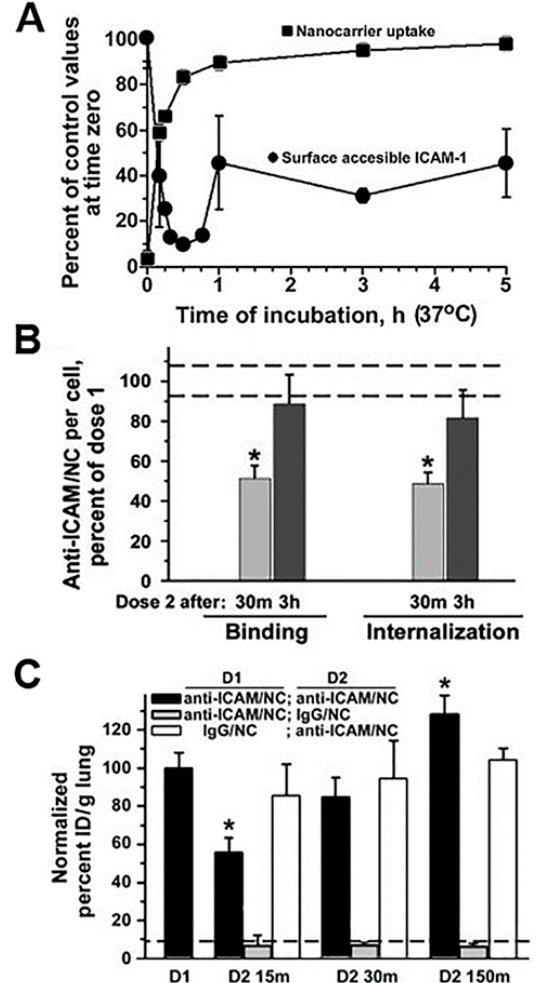
Figure 6. Endocytic alterations caused by drug carriers. ( A ) Kinetics of endocytosis of via intercellular adhesion molecule 1 (ICAM-1)-targeted polymer nanocarriers (anti-ICAM/NCs) by HUVEC cells (traced by fluorescence microscopy) and that of cell surface levels of ICAM-1 receptor during nanocarrier uptake (traced by radioactive labeling). ( B ) Relative level of binding and endocytosis of anti-ICAM/NCs applied as a second dose to HUVEC cells (and traced by fluorescence microscopy), either 30 min or 3 h after a first dose of NCs. * p < 0.05, Student’s t test. ( C ) Lung targeting, expressed as % injected dose per gram of tissue (%ID/g; radioactive tracing), of a first dose of anti-ICAM/NCs injected i.v. in mice vs. that of NCs applied as a second dose 15, 30, or 150 min after the first dose. Control non-specific IgG/NCs are also shown. Data are mean ± SEM, compared by Student’s t test. Adapted and reproduced with permission from Figures 1 and 3 in [64]. Copyright 2005 The American Sociaty of Hematology.